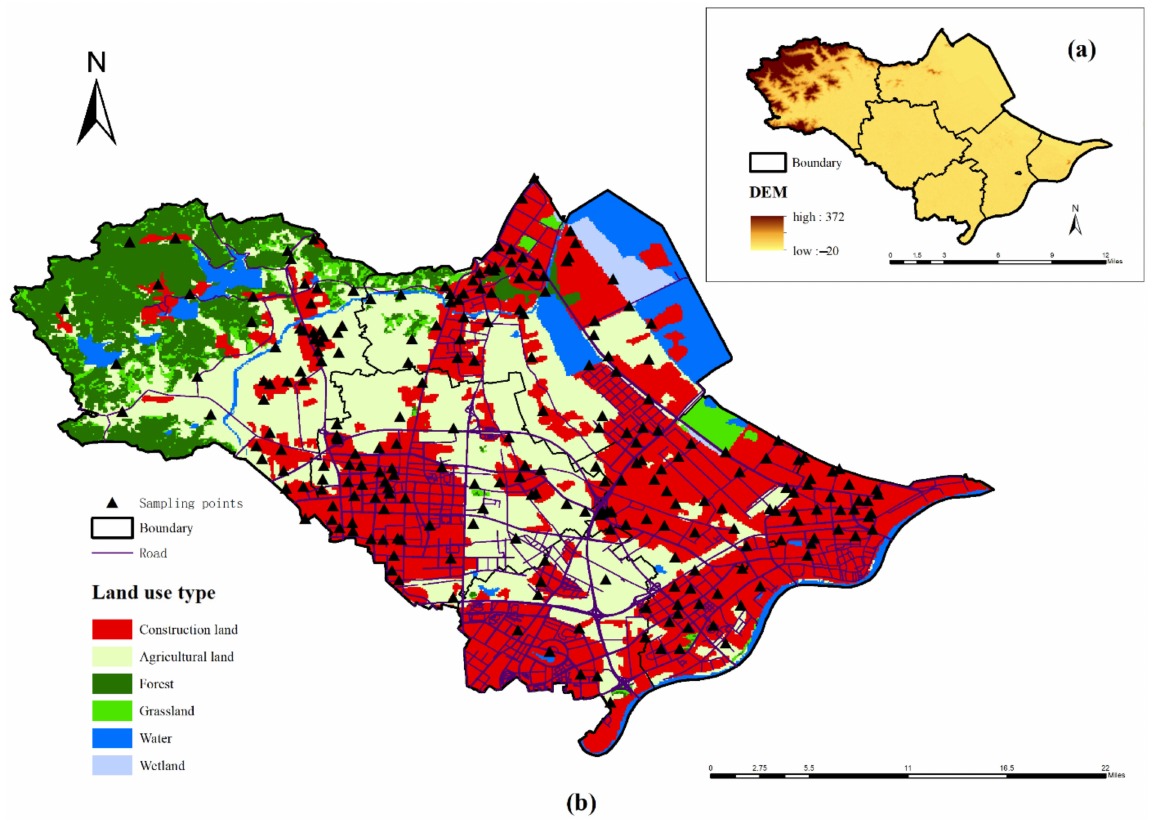
Figure 1. ( a ) Basic information illustrated by the digital elevation model and ( b ) distribution of the sampling points on the land-use type map of the study